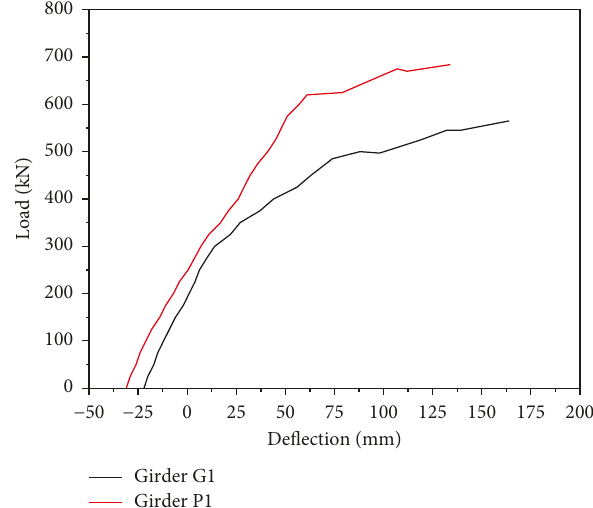
Figure 10: Load–net deflection curves at midspan for girders G1 and P1.